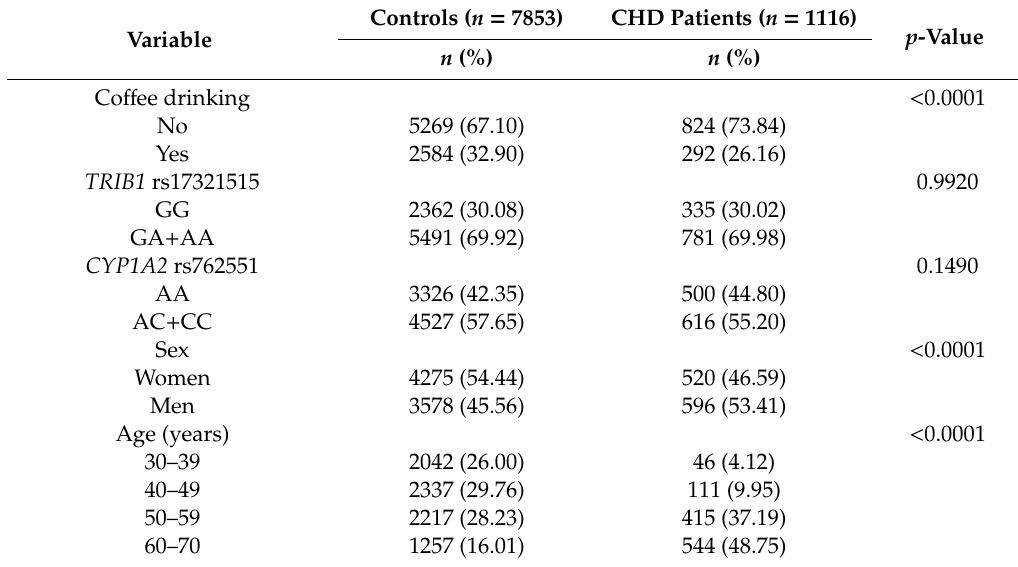
Table 1. Descriptive data of the study